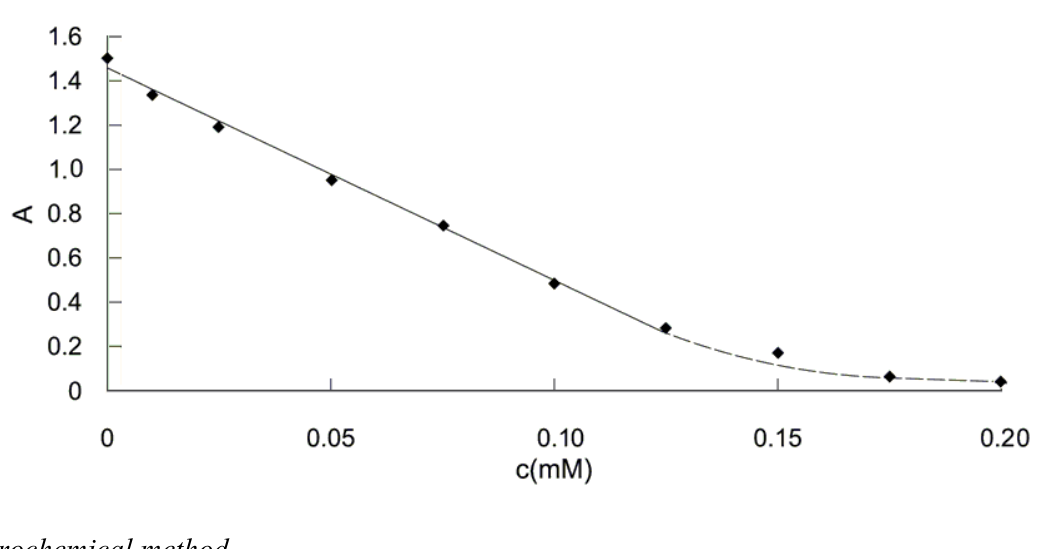
Figure 2 . Absorbance variation for DPPH· 0.12 mM, in the presence of different Trolox ®